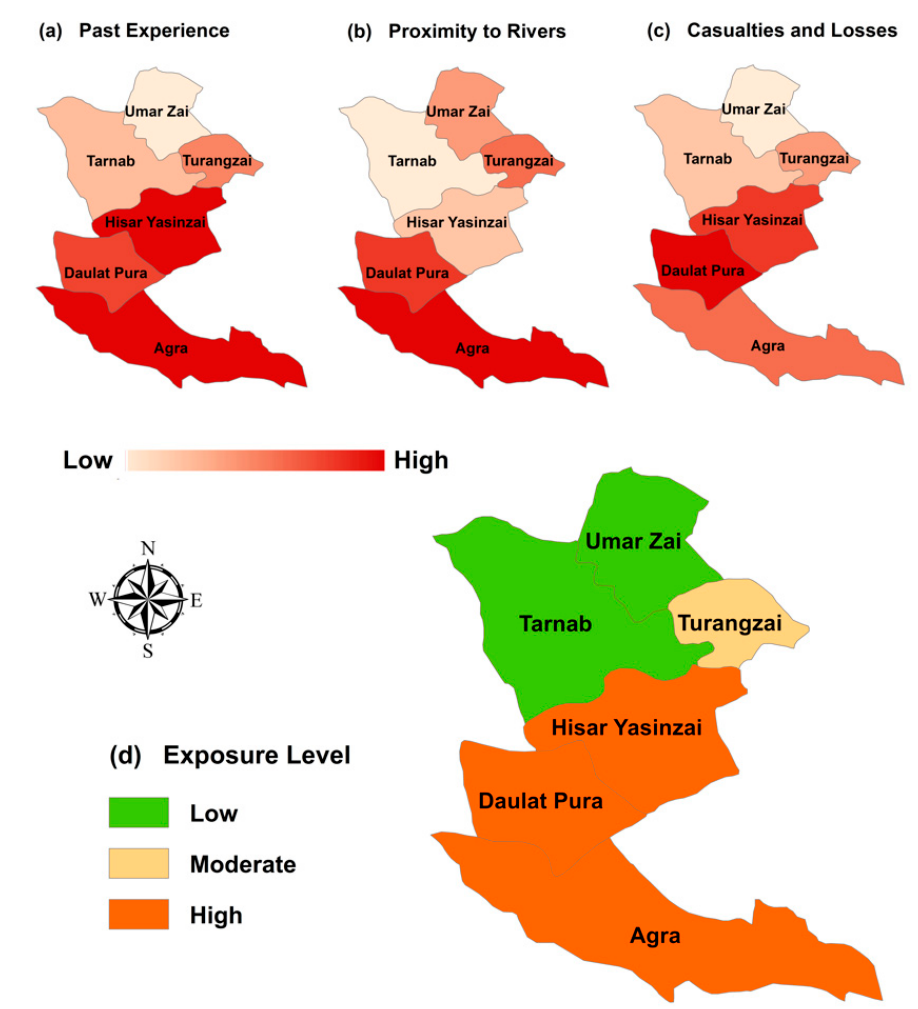
Figure 8. Geographical distribution of indicators and levels of exposure. ( a ) represents the geographi- cal distribution of households with past flood experience; ( b ). represents the geographical distribution of households’ proximity to rivers; ( c ). represents the geographical distribution of households with casualties and losses in previous floods; ( d ). represents the geographical distribution of households’ exposure level. Table 4. Household exposure to floods.